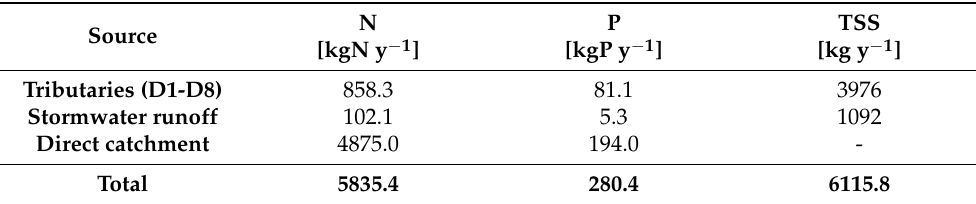
Table 8. External load of nitrogen (N), phosphorus (P) and total suspended solids (TSS) to Raczy´nskie Lake from different sources in a typical